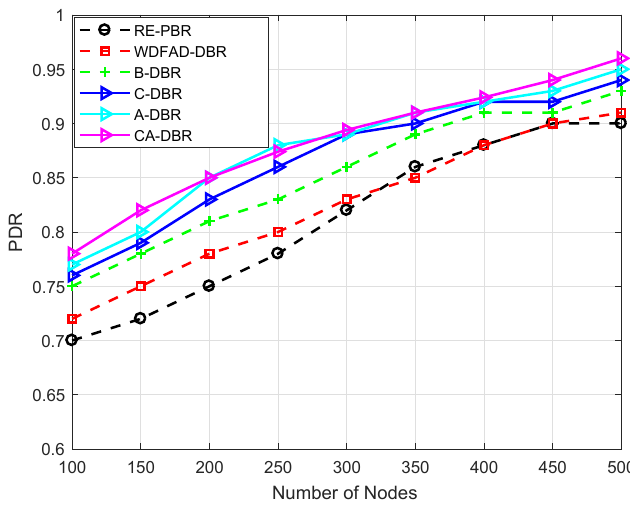
Figure 9. Comparison of Packet Delivery Ratio (PDR).